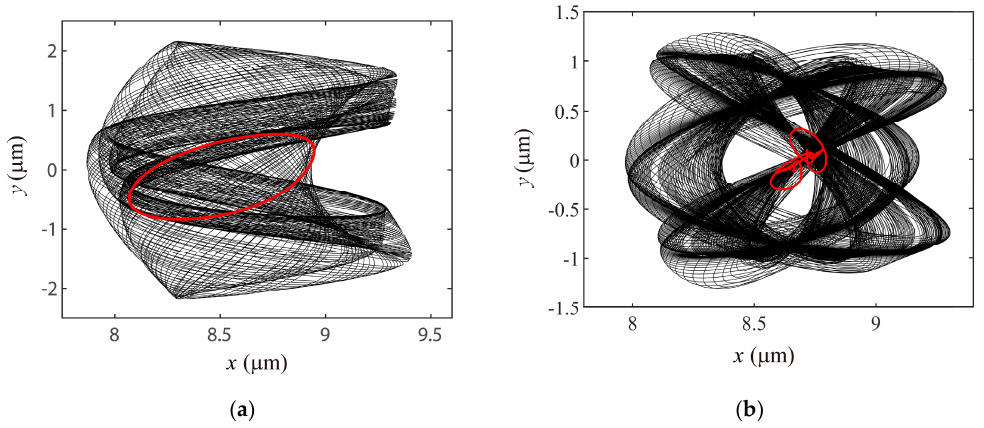
Figure 24. For δ 0 = 4.0 μ m, the orbits (black line) and their Poincare mappings (red dots) of the VC quasi-period motion when ( a ) Ω = 126 rad/s, and ( b ) Ω = 154.6 rad/s.